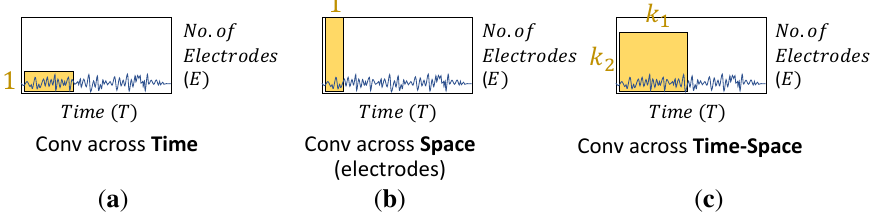
Figure 2. EEG convolution filter types include ( a ) temporal filter, ( b ) spatial filter, and ( c ) temporal- –spatial filter. The yellow blocks denote the two-dimensional (2D) kernel for performing feature